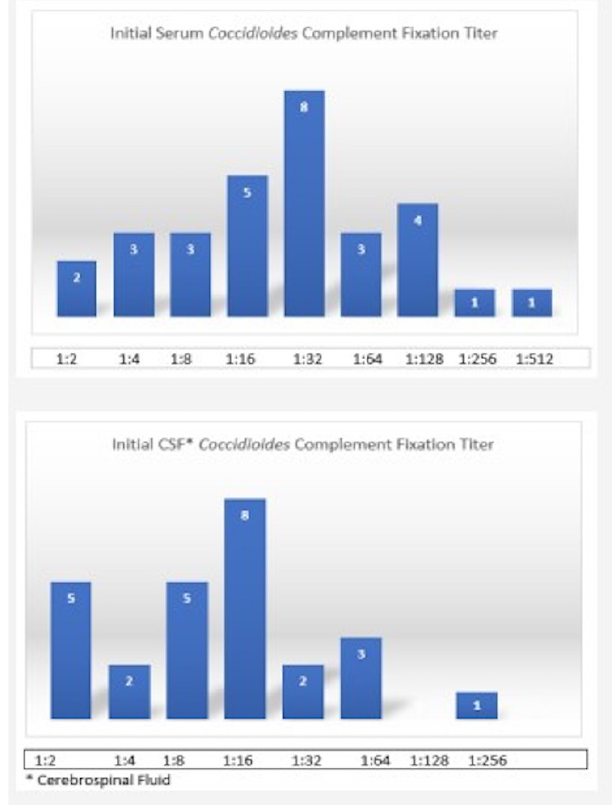
Figure 1. Serum and cerebrospinal fluid serological trends in study patients. Table 2. Management and Follow-up of CM * (N = 37).